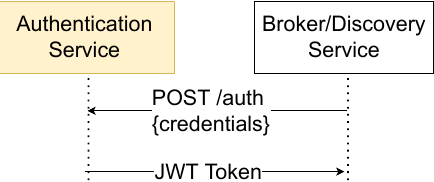
Figure 6. Communication with authentication service